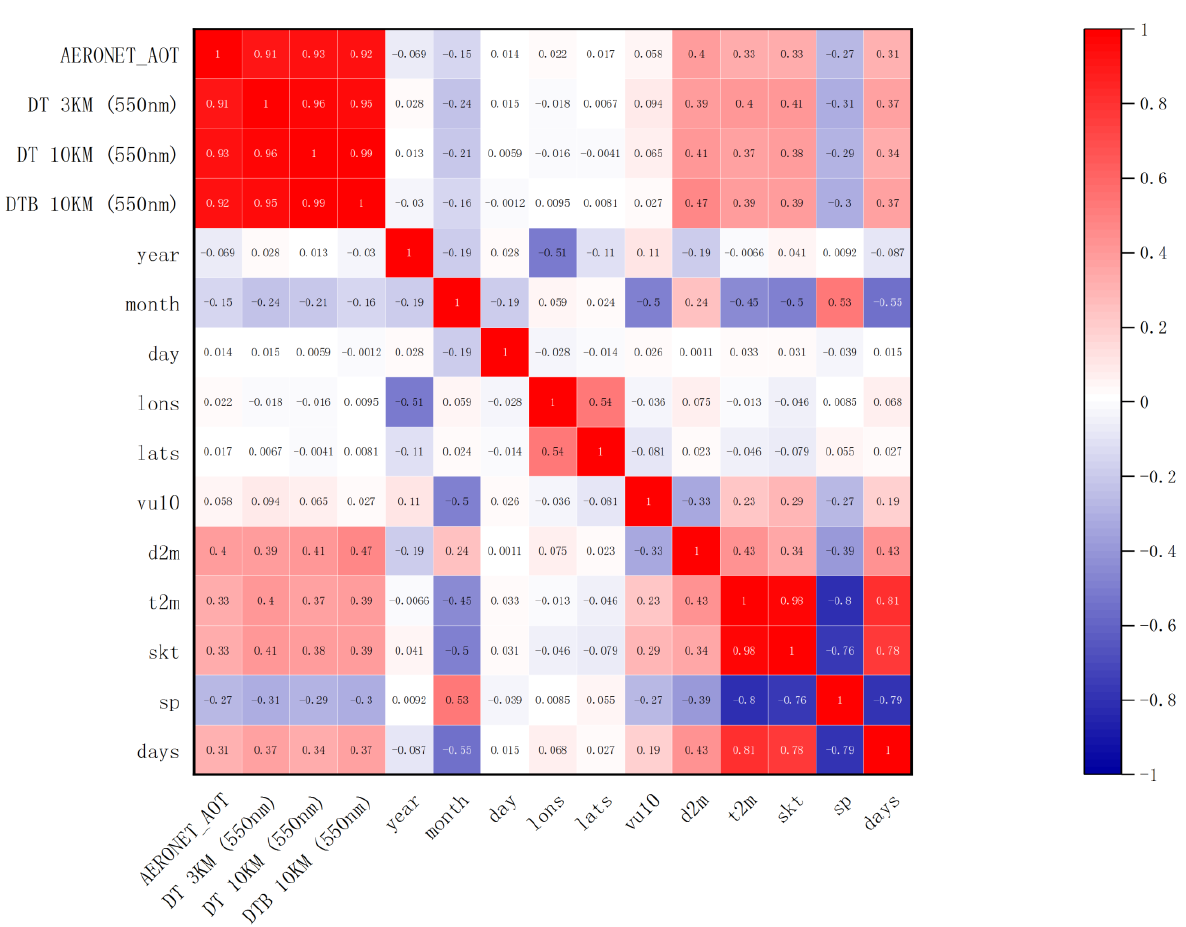
Figure 1 . Flowchart of the proposed bias correction method